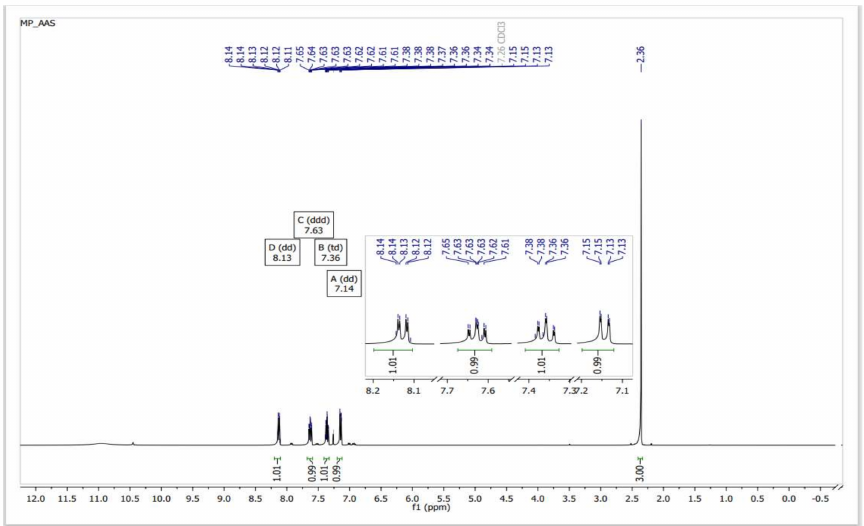
Figure 3. 1 H NMR spectra of a sample of MS obtained from the transesterification–esterification of ASA catalyzed by SiO 2 –SO 3